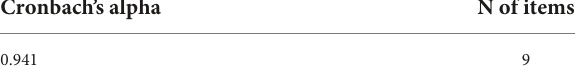
TABLE 1 Reliability statistics of sense of virtual community (SOVC)